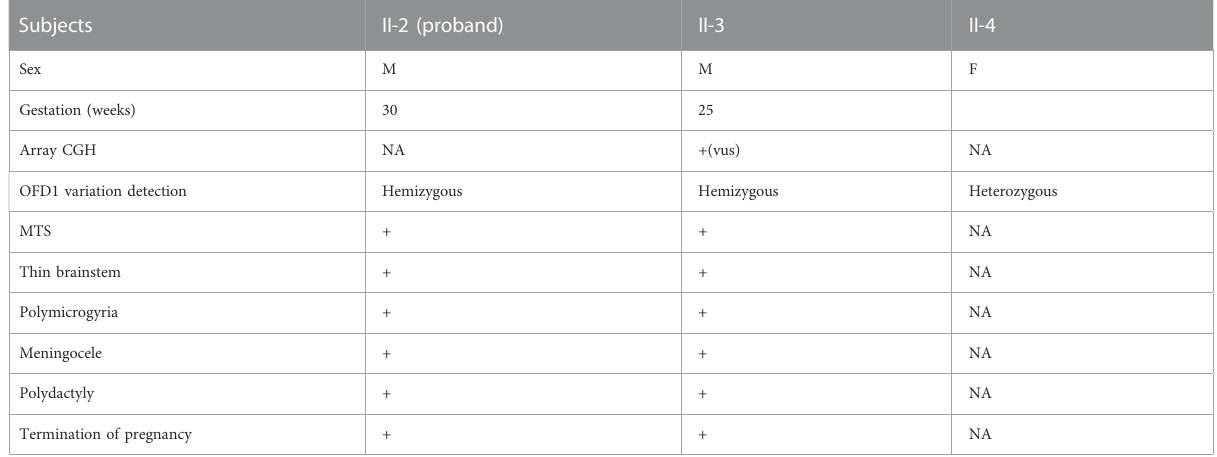
TABLE 1 Clinical data of three fetuses in this